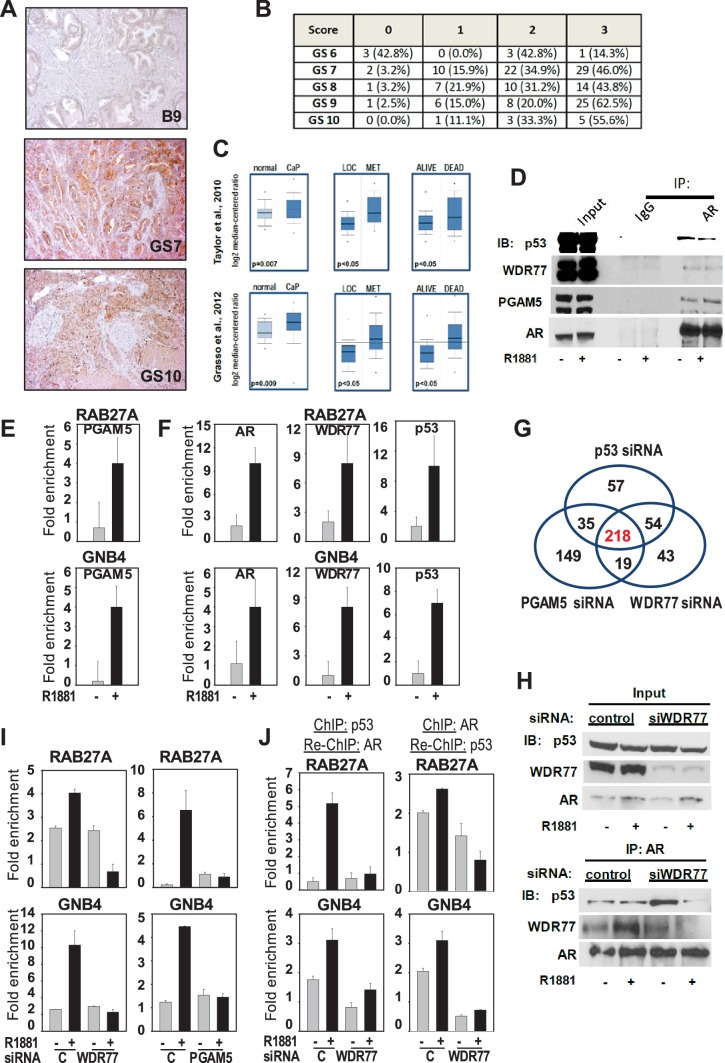
Mechanism underlying WDR77-dependent AR and p53 interaction.(A) Representative images of prostate and CaP TMA cores that were subjected to immunohistochemistry using an antibody directed against PGAM5. B9, benign prostate; GS, Gleason score. 10x magnification. (B) Overview of quantitation of PGAM5 immunohistochemistry on CaP cores. Columns represent different scores. Rows represent CaP cores that are grouped according to Gleason scores. GS, Gleason score. Number, number of TMA cores; %, percentage of cores per GS group. (C) Oncomine analyses done on 2 CaP gene expression profiling studies. PGAM5 mRNA expression was determined in normal prostate versus CaP (left panels), in localized (LOC) CaP versus metastatic (MET) CaP (middle panels), and taken into consideration follow-up information on 5 year survival status of patients (alive or dead). Figure 5—source data 1 provides more information on PGAM5 peptides identified using IP-mass spectrometry. (D) Co-immunoprecipitation assay shows interaction between AR, WDR77, PGAM5 and p53. Co-IP is done in LNCaP cells after 16 hr treatment with R1881 or vehicle. IP, immunoprecipitation; IB, immunoblotting. (E) ChIP validation of androgen-dependent recruitment of PGAM5 to AREs within WDR77-responsive AR target genes RAB27A and GNB4. Results reflect the effect of 16 hr treatment of LNCaP cells with 5nM R1881 or vehicle. (F) ChIP validation of androgen-dependent recruitment of AR, PGAM5 and p53 to the same AREs within WDR77-responsive AR target genes RAB27A and GNB4. Culture conditions are as under E. (G) Overlap in genome-wide p53-, WDR77-, and pGAM5-dependent androgen-responsive gene expression. Results reflect the effect of 48 hr treatment of LNCaP cells with 5nM R1881. R1881 or vehicle treatment was administered 42 hr after siRNA transfection. Numbers, number of genes. (H) Co-immunoprecipitation assay demonstrates WDR77-dependence of AR and p53 interaction. Co-IP is done in LNCaP cells after 16 hr treatment with R1881 or vehicle. Treatment was given 72 hr after transfection using siRNAs targeting WDR77 or control siRNAs. (I) ChIP validation of reliance of androgen-dependent recruitment of p53 to WDR77-responsive AREs on WDR77 and PGAM5. Culture conditions are as under E. (J) ChIP-re-ChIP experiments validate androgen- and WDR77-dependent co-recruitment of p53 and AR to the same GNB4 and RAB27A gene regions. Culture conditions and data representation is as under H. Data shown in panels D-I are derived from LNCaP cells.10.7554/eLife.28482.016Figure 5—source data 1.PGAM5 peptides identified after IP-mass spectrometry.